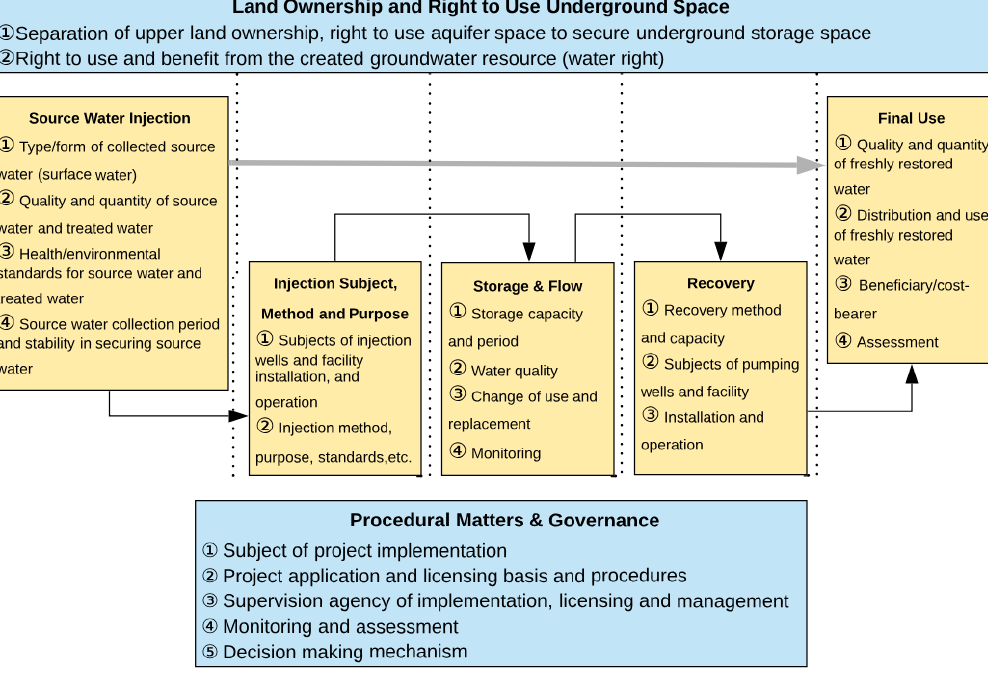
Figure 3. Main legal issues and components in each phase of the ASWQE project.